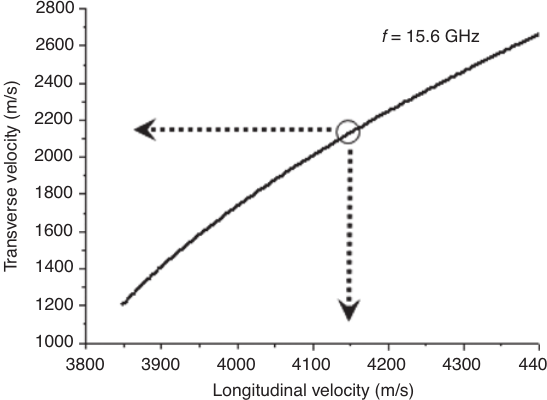
Figure 20: Black curve corresponding to the different couples of v and v which give the first breathing mode frequency equal to 15.6 t GHz obtained in 91 nm diameter single copper nanowires [109]. The black arrow pointed out the standard velocities in polycrystalline copper around 4150 m.s −1 and 2150 m.s −1 , respectively, for longitudinal and transverse sound